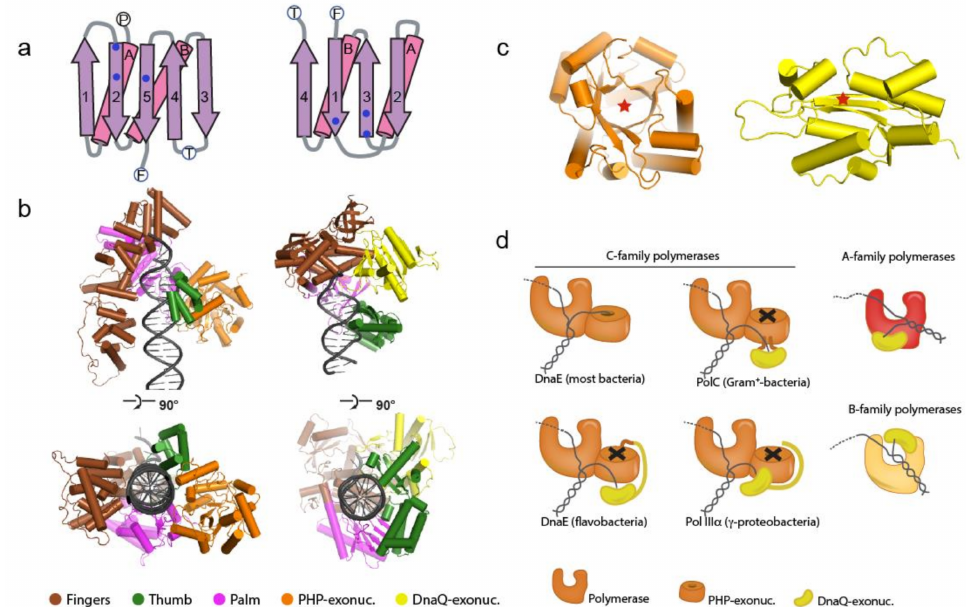
Figure 2. Unique features of bacterial replicative DNA polymerases. ( a ). The active site of the bacterial replicaseconsistsofa5-strandedparallel / antiparallel β -sheet. Theactivesiteoftheeukaryoticreplicative DNA polymerase contains 4-stranded, all antiparallel β -sheet. Catalytic site residues, marked with blue dots, are located at opposite site of the β -sheet—adapted from [28]. ( b ). Comparison of the bacterial replicative DNA polymerase (left, PDB: 5FKW, EMDB: 3202) and the eukaryotic replicative DNA polymerase δ (right, PDB: 3IAY). Domains are indicated with di ff erent colors. The C-terminal tail of bacterial polymerase is omitted for clarity. ( c ). The Polymerase and Histidinol Phosphatase (PHP)-exonuclease (left) and DnaQ-type exonuclease (right) are structurally distinct. The red star indicates the location of active site ( d ). Schematic representation of the di ff erent polymerase families, highlighting the di ff erent locations of the PHP- and DnaQ-exonuclease domains. Black cross marks inactive